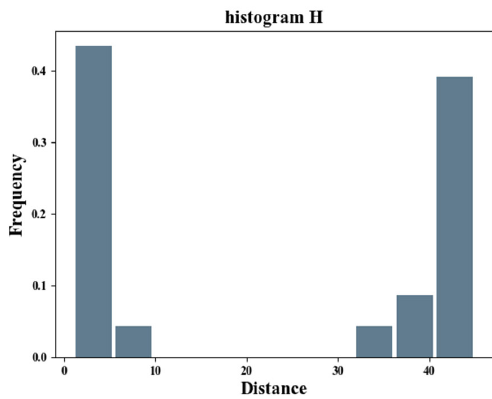
Figure 4. Histogram H.